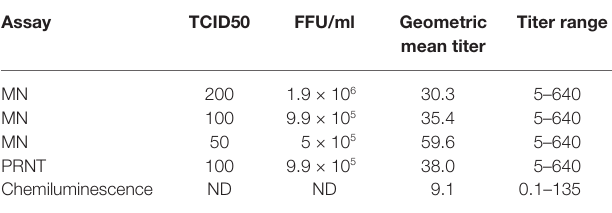
TABLE 1 | Geometric means and ranges of titers resulting from various neutralization